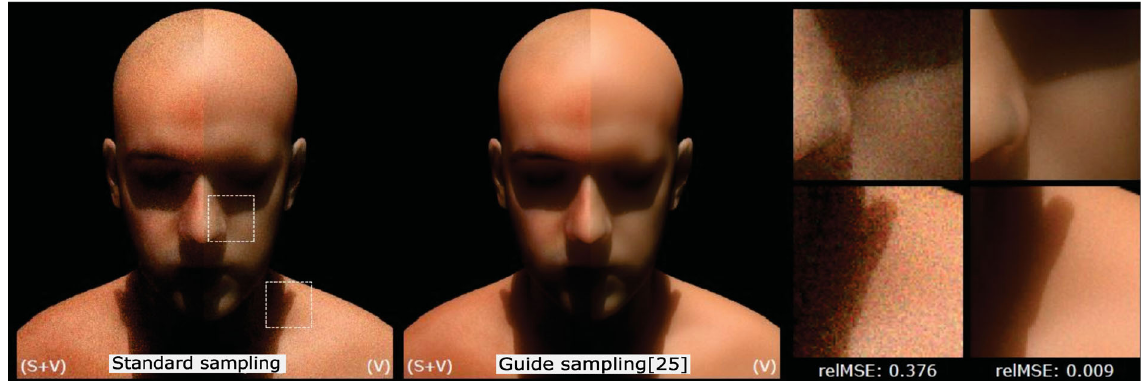
Fig. 12 Comparison between standard sampling and path guiding from Herholz et al. [3]. Reproduced with permission from Ref. [3], c (cid:2) The Author(s)